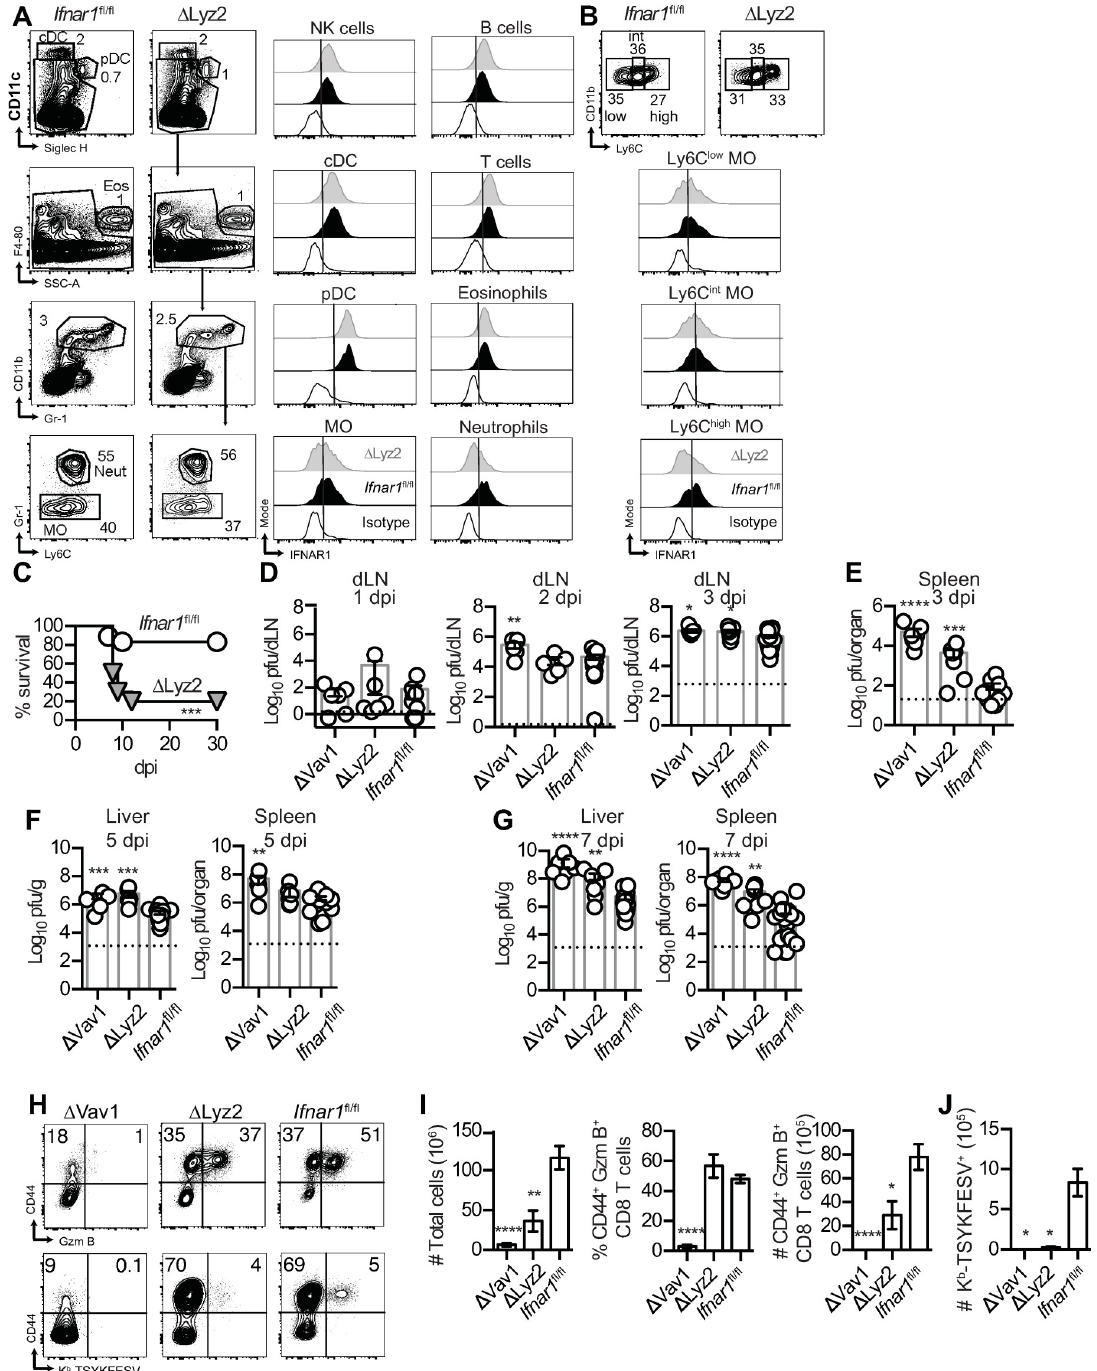
Fig 6. Intrinsic IFNAR in Lysozyme-expressing myeloid cells is necessary for resistance to mousepox. (A) Concatenated flow cytometry plots showing the gating strategy for cDCs (CD19 - TCR β - NK1.1 - CD11c high SiglecH - ), pDCs (CD19 - TCR β - NK1.1 - CD11c + SiglecH + ), eosinophils (CD19 - TCR β - NK1.1 - SiglecH - F4-80 + SSC-A high ), MO (CD19 - TCR β - NK1.1 - SiglecH - CD11b + Gr-1 + Ly6C low/high ), and neutrophils (CD19 - TCR β - NK1.1 - SiglecH - CD11b + Gr-1 high ) and concatenated histograms showing IFNAR expression in indicated cell populations from spleens of na ï ve Ifnar1 fl/fl and Ifnar1 Δ Lyz2 mice. (B) IFNAR1 expression in Ly6C low , Ly6C int , and Ly6C high gated MO. Histogram legend as in (A) . Representative data from one out of two independent experiments (N = 6 to 7 for each group). (C) Survival of the indicated mice infected s.c. with 3000 pfu of ECTV-GFP. Data pooled from two independent experiments (N = 10 for Ifnar1 Δ Lyz2 mice and N = 18 for Ifnar1 fl/fl mice, Log-rank Mantel-Cox